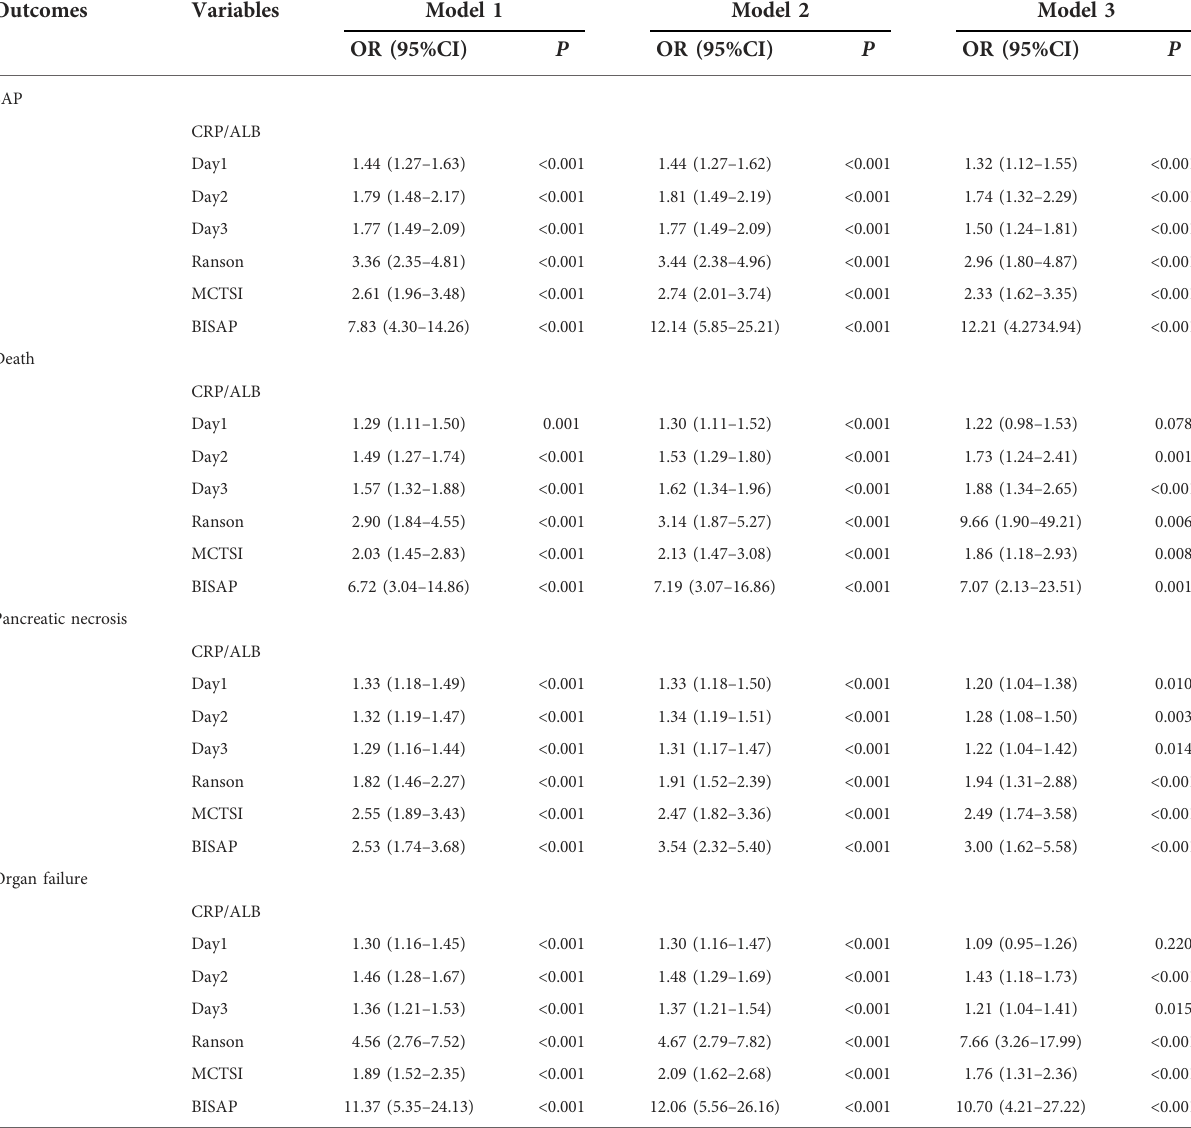
TABLE 5 The prognosis values of CRP/ALB ratio, ranson, MCTSI, and BISAP in